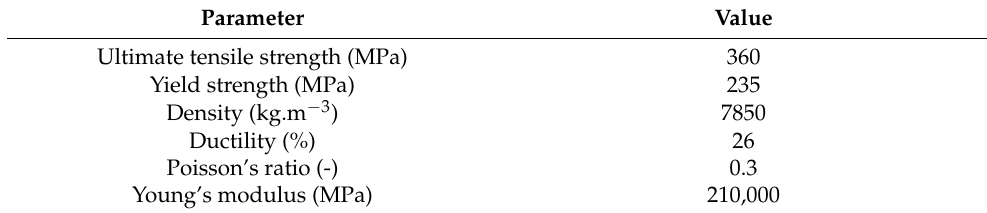
Table 2. Parameters of the material S235JR [36].